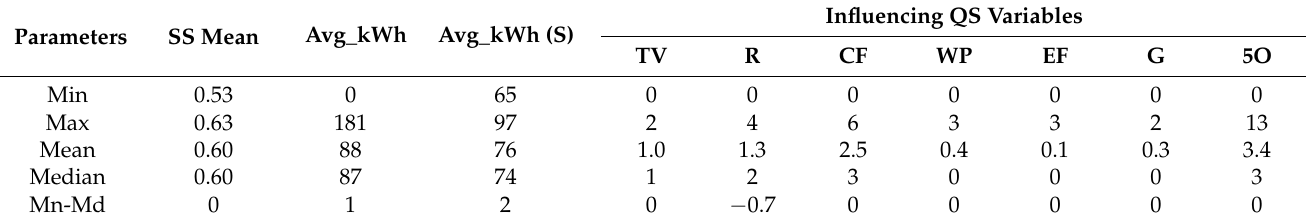
Table 10. 2nd-stage SOM + KM with clustering analysis of